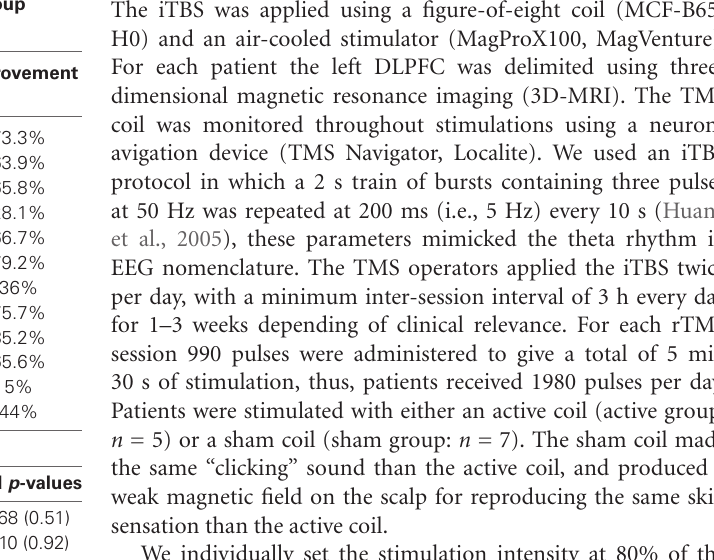
FIGURE 1 | Experimental design (D = day, S1 and S2 = first and second AS task sessions) . On D-3 two AS task sessions are performed for training purposes. Repetitive TMS treatment was administered every day